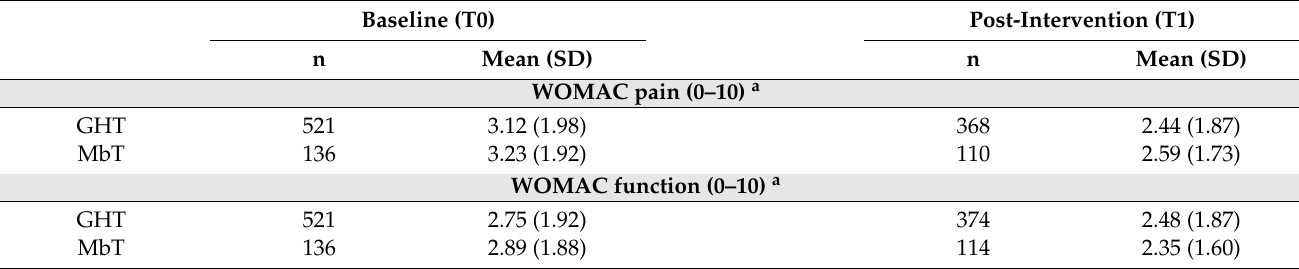
Table 3. Descriptions of the WOMAC pain and function scores at T0,